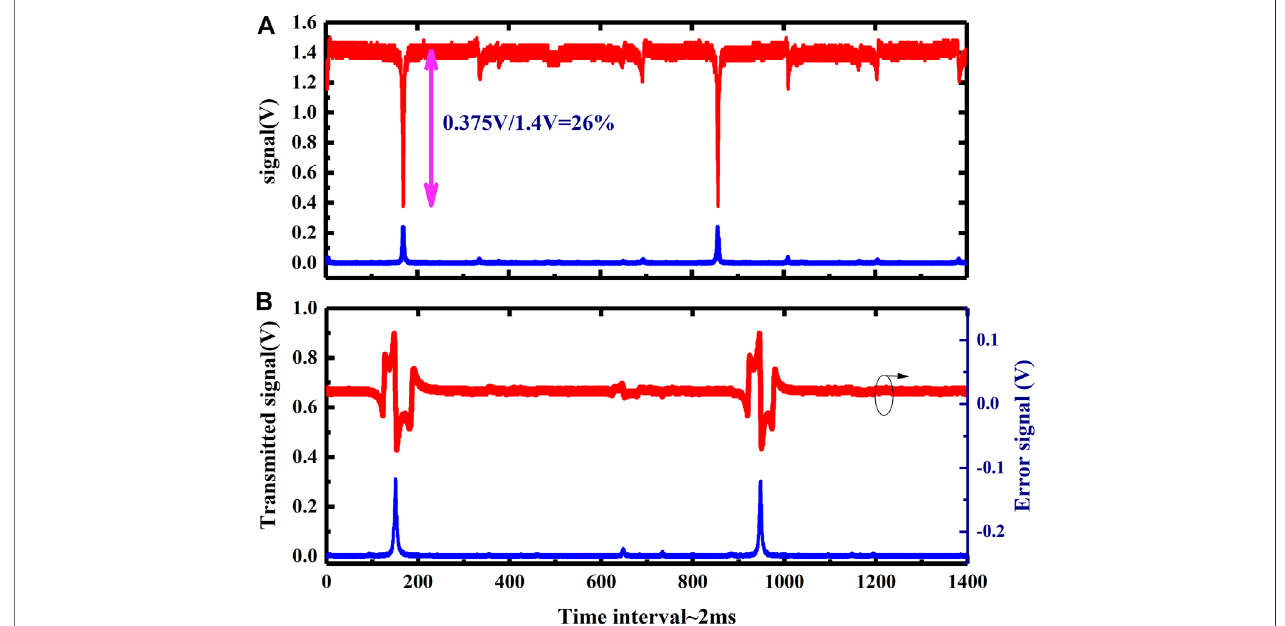
FIGURE 5 | (A) Re fl ection peaks (red) and transmission peaks (blue) of the 335.5 nm resonant cavity; (B) error signals (red).